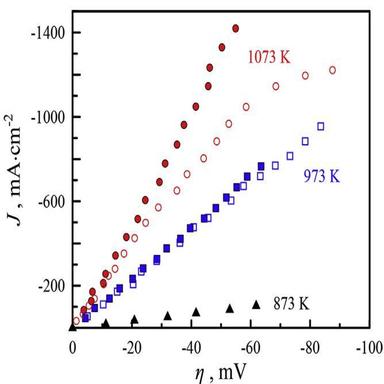
Polarization curves for PYBCN/SDC (filled) and PYBC/SDC (open) composites with 70/30 wt% ratio of constituent phases.